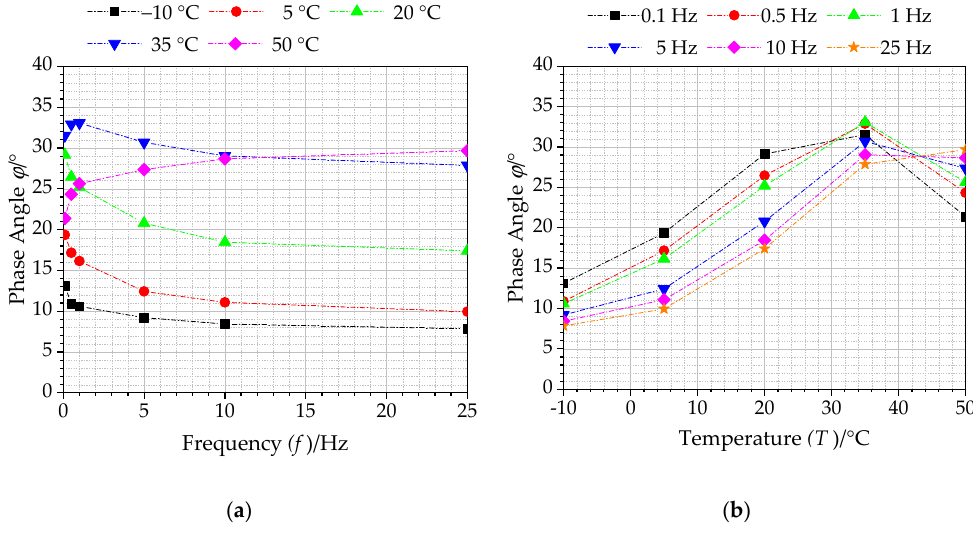
Figure 7. Phase angles of asphalt mixtures with basalt fiber: ( a ) temperature, ( b ) frequency.